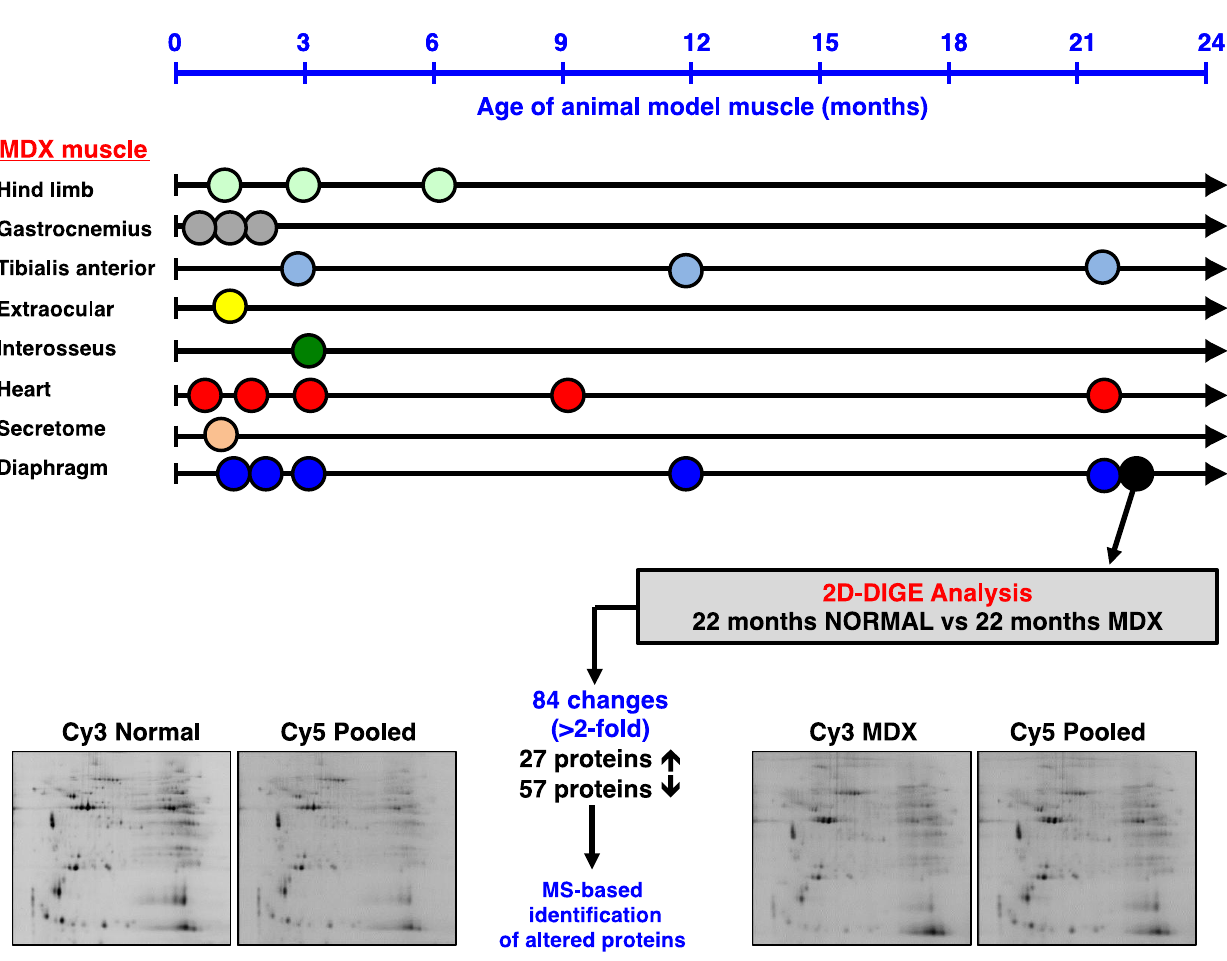
Figure 2. Mass spectrometry-based proteomic profiling of the mdx mouse model of Duchenne muscular dystrophy: The upper panel of the figure summarizes the types of muscle and age groups of mdx mice that have been used over the last few years to identify global changes in the dystrophic muscle proteome. All listed proteomic studies have been recently discussed in comprehensive reviews of the proteomics of the dystrophin-glycoprotein complex and dystrophinopathy [50,69]. The lower panel gives an overview of the difference in-gel electrophoretic (DIGE) analysis of the aged mdx diaphragm muscle presented in this